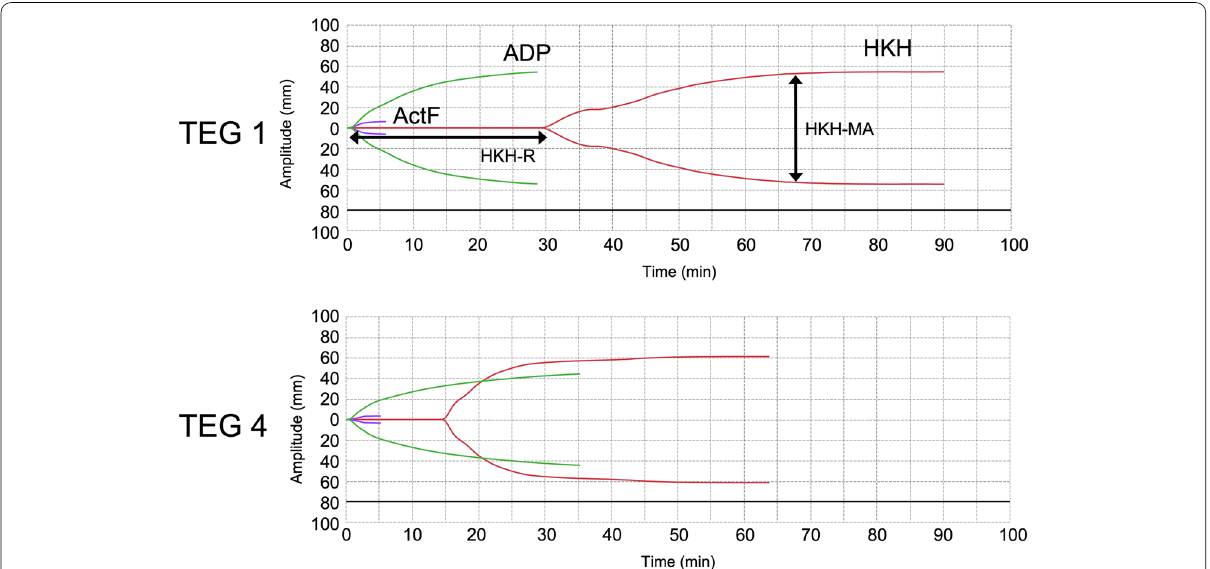
Fig. 2 Raw data of thromboelastography (TEG) before (TEG 1) and after surgery (TEG 4). The normal value of HKH-R is 4.2–9.8 min, and the normal value HKH-MA is 53–68 mm. The HKH-R was prolonged preoperatively (TEG 1) and shortened postoperatively (TEG 4) by continued intraoperative platelet transfusions. HKH heparinized kaolin with heparinase, ActF activator F, ADP adenosine